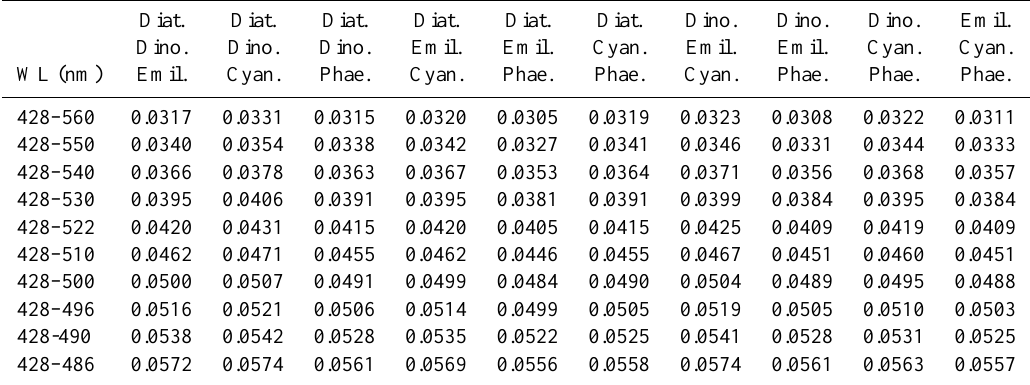
Table A1. Summation of scalar products of specific absorption spectra for all 3-element sets of major phytoplankton species for different wavelength-windows. Diat. Diat. Diat. Diat. Diat. Diat. Dino. Dino.